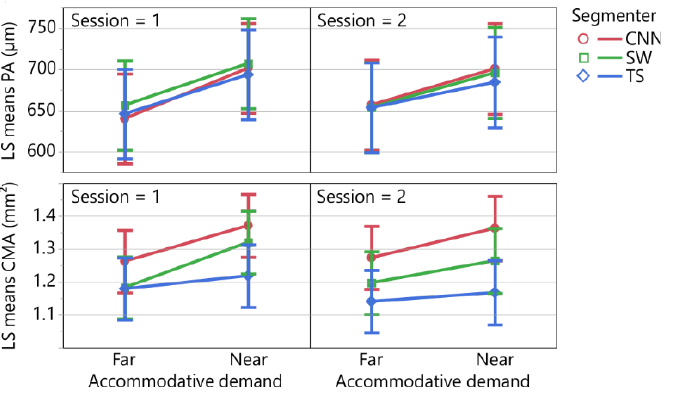
Figure 5. Least-square means plots of the results of the linear mixed-effects models for the dependent variables perpendicular axis (PA, top ) and ciliary muscle area (CMA, bottom ) for the fixed effects accommodative demand, segmenter, and session. In both models, the accommodative demand was found to be statistically significant. Only for the CMA, the segmenter was shown to also have a statistically significant effect.